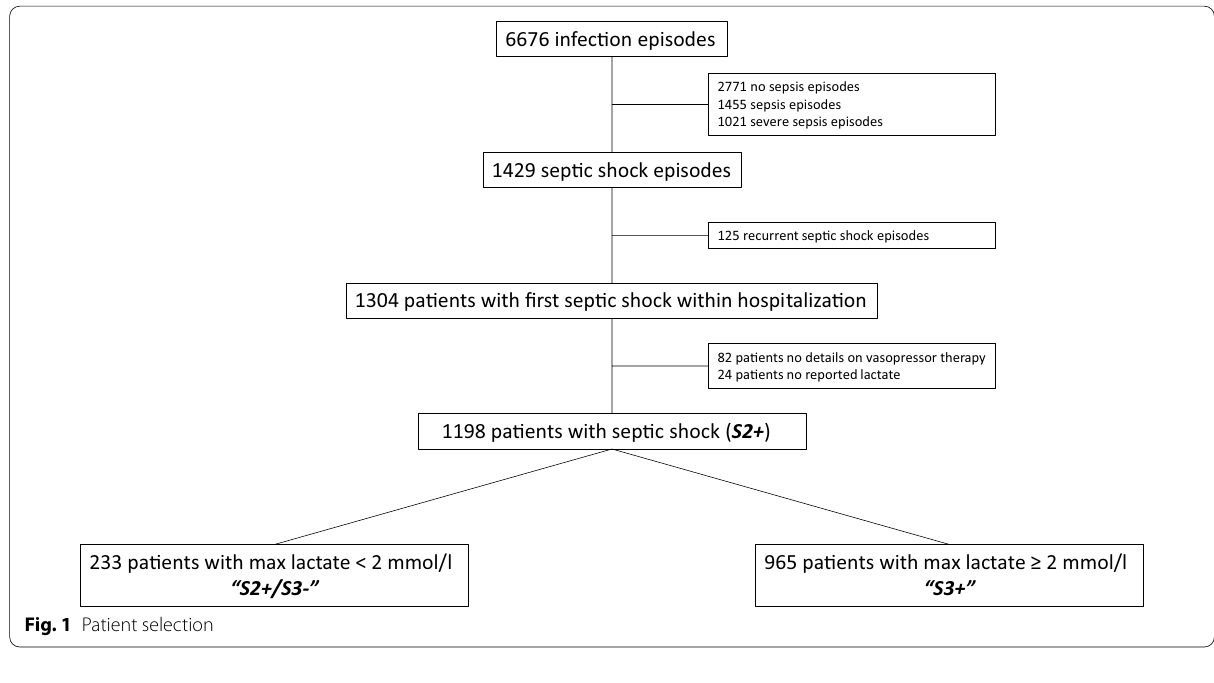
Table 1. S2 /S3 patients more frequently had a medi- + −